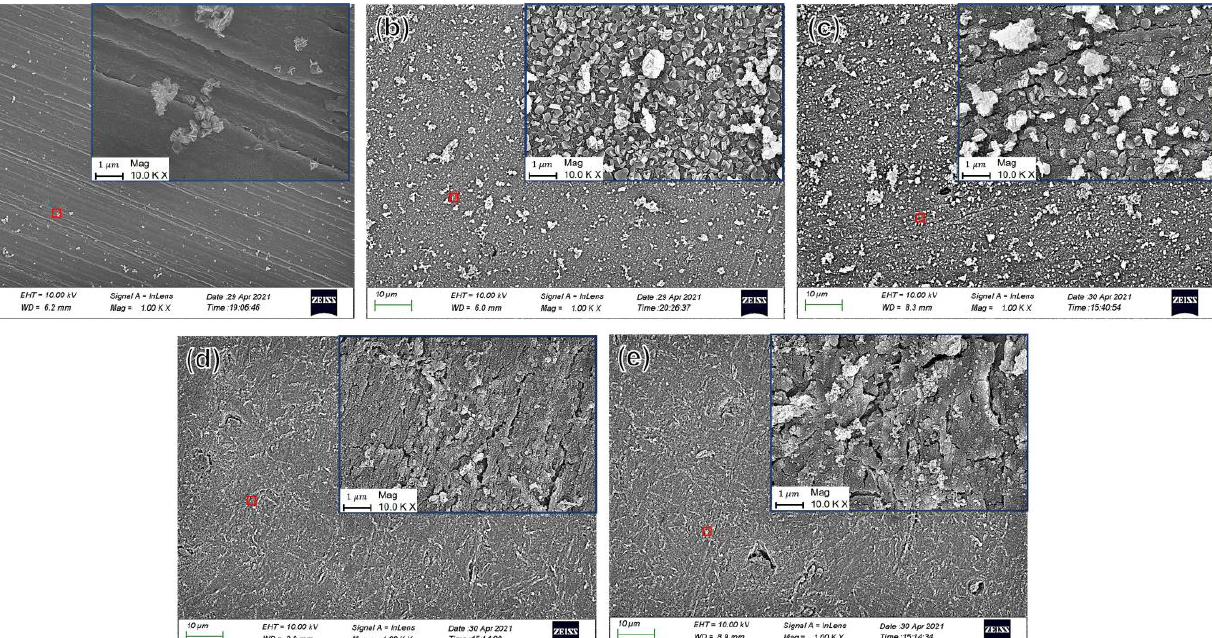
Table 4. Fitted EIS parameters of X80 steel samples after applying various strains and i DC = 2 mA/cm 2 . DC Density Strain